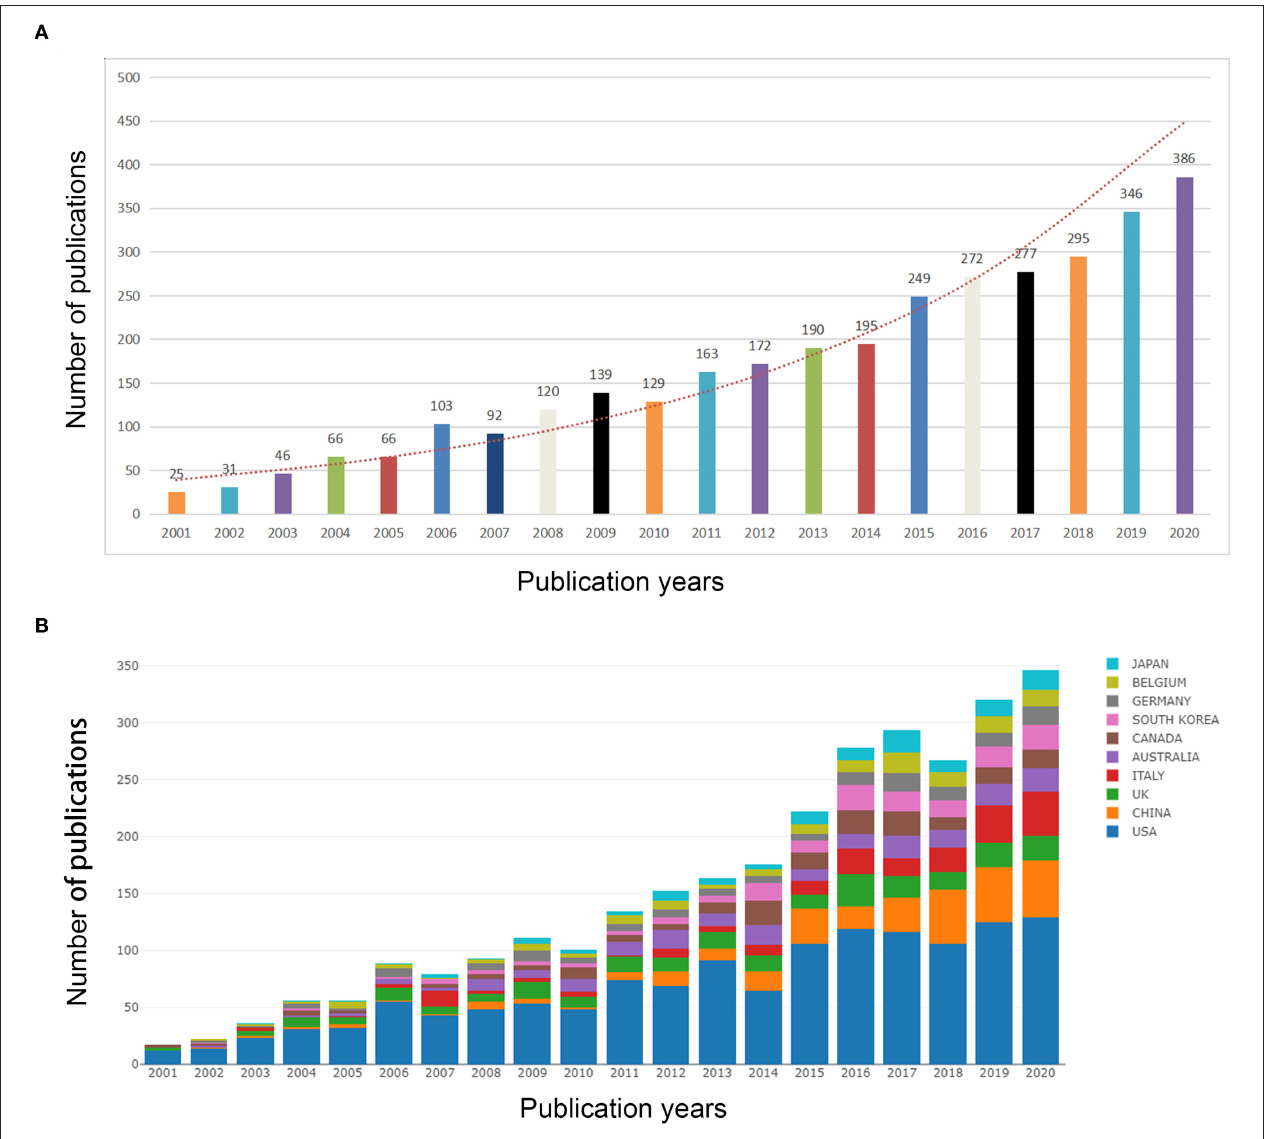
FIGURE 2 | Trends in the number of publications (A) and the top-10 countries/regions (B) of CRS-treatment research from 2001 to 2020.